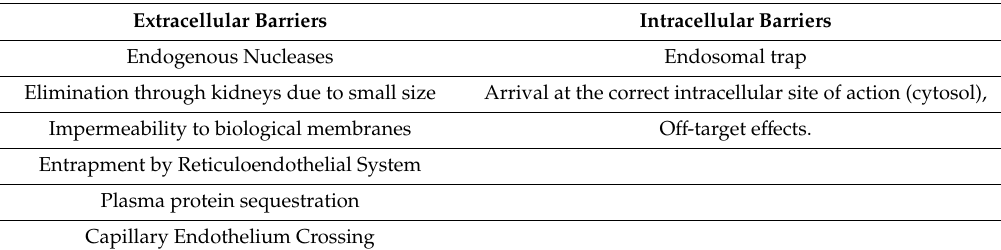
Table 2. Barriers faced by siRNA to reaching site of